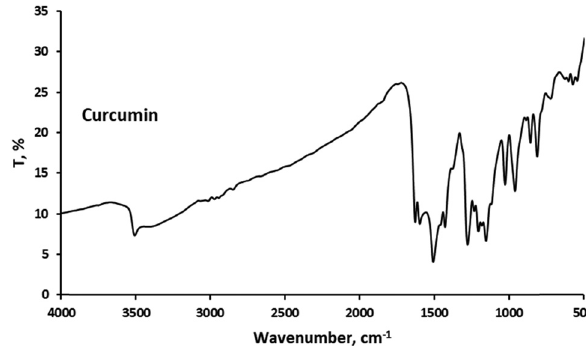
Figure 3: Fourier transform infrared spectra of curcumin ( Cur )